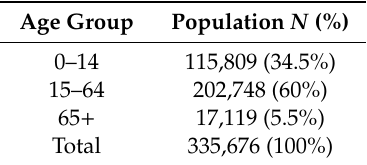
Table 1. Population statistics by age from the 2011 census for the GTM (statistics South Africa).